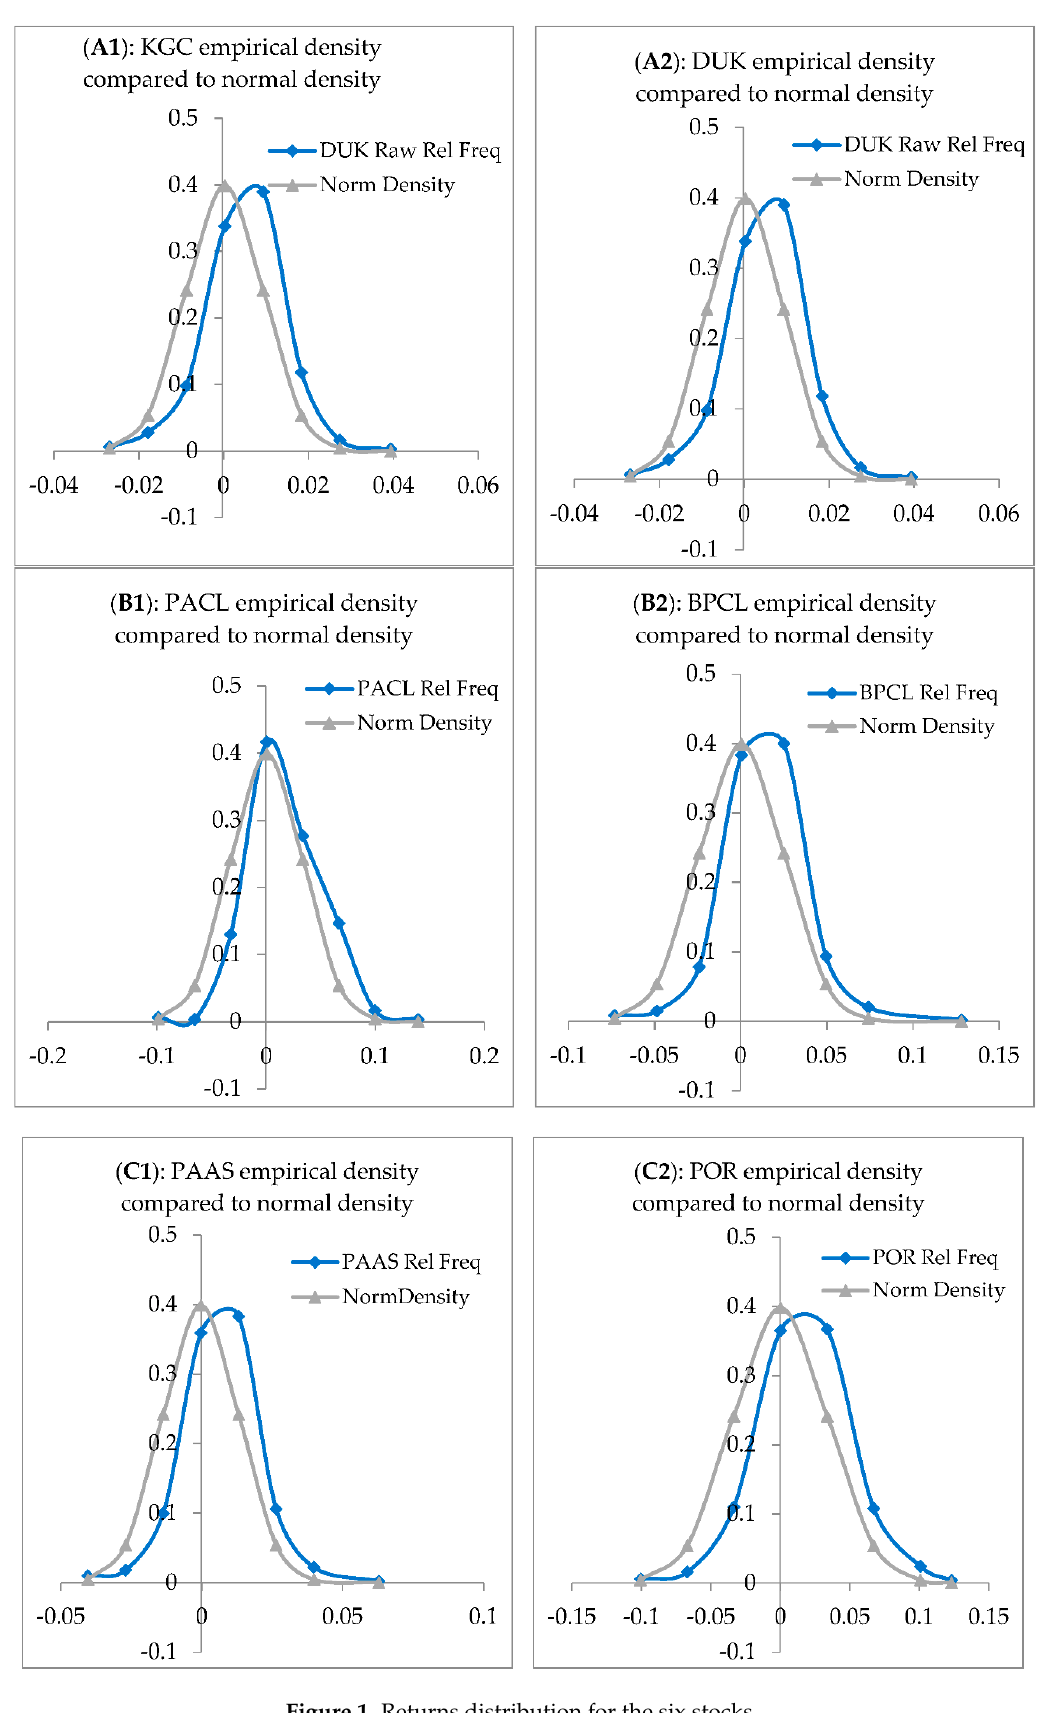
Figure 1. Returns distribution for the six stocks.